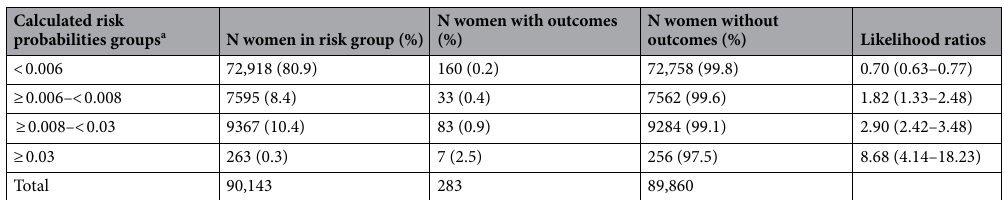
Table 4. Risk classification and stratification table for prediction of type 2 diabetic complications among women with gestational diabetes mellitus, at 10 years of follow-up. a Calculated predicted risks of developing the outcome grouped into different risk categories for